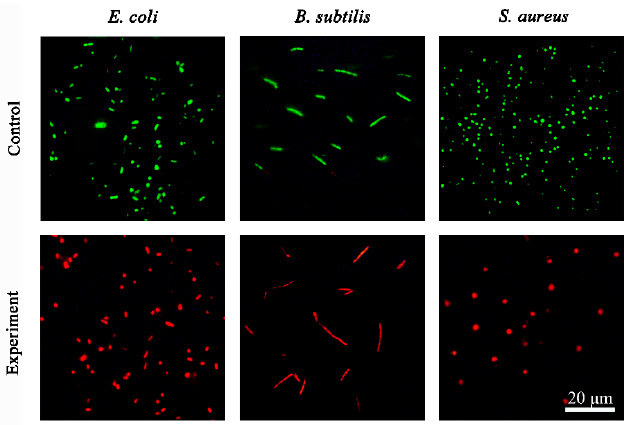
Figure 5. Fluorescence images of the bacteria ( E. coli , B. subtilis , S. aureus ) stained with SYTO 9 and PI. Scale bar 20 μ